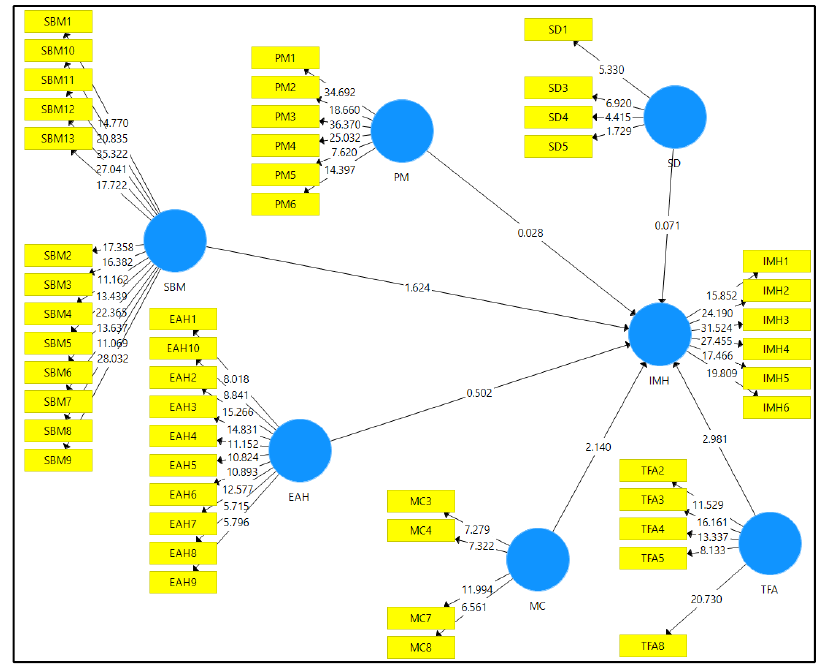
Figure 3. Structural